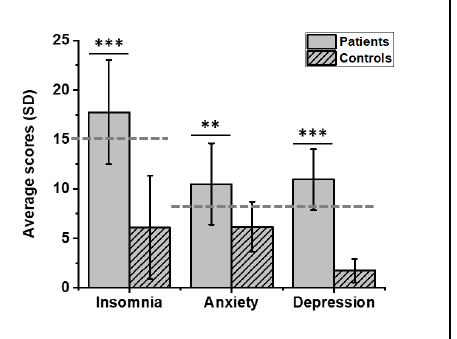
Figure 2. Sleep and mood scores in FM patients and controls. Dashed horizontal lines represent respective threshold scores for clinically significant insomnia (ISI ≥ 15), anxiety, and depression (HADanx and HADdep ≥ 8). Different levels of significance are represented, respectively, by ** ( p < 0.01) and *** ( p < 0.001). The ISI average score disclosed moderate insomnia in FM patients (17.75(5.27)) and was significantly higher than controls who had no insomnia (6.09(5.22), p < 0.001). Patients were at the limits of moderate anxiety (10.50(4.12)) and depression (10.94(3.07)), while controls had normal scores (respectively, 6.18(2.52), p = 0.005; 1.71(1.19), p < 0.001).